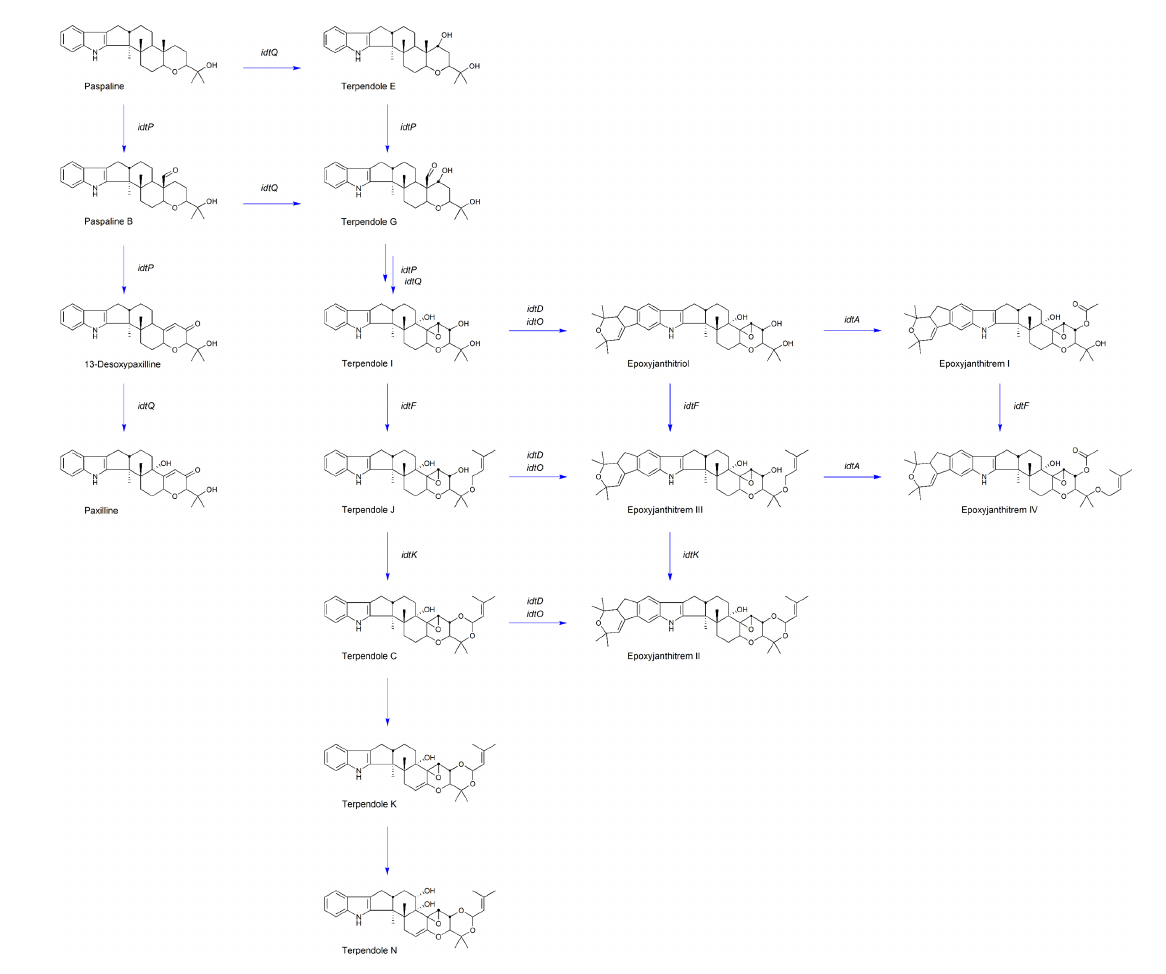
FIGURE 3 AR37 epoxyjanthitrem biosynthetic pathway. Key compounds proposed in the epoxyjanthitrem biosynthetic pathway in AR37. The compound name is labelled below the structure, with the corresponding gene involved in the compound production labelled next to the associated